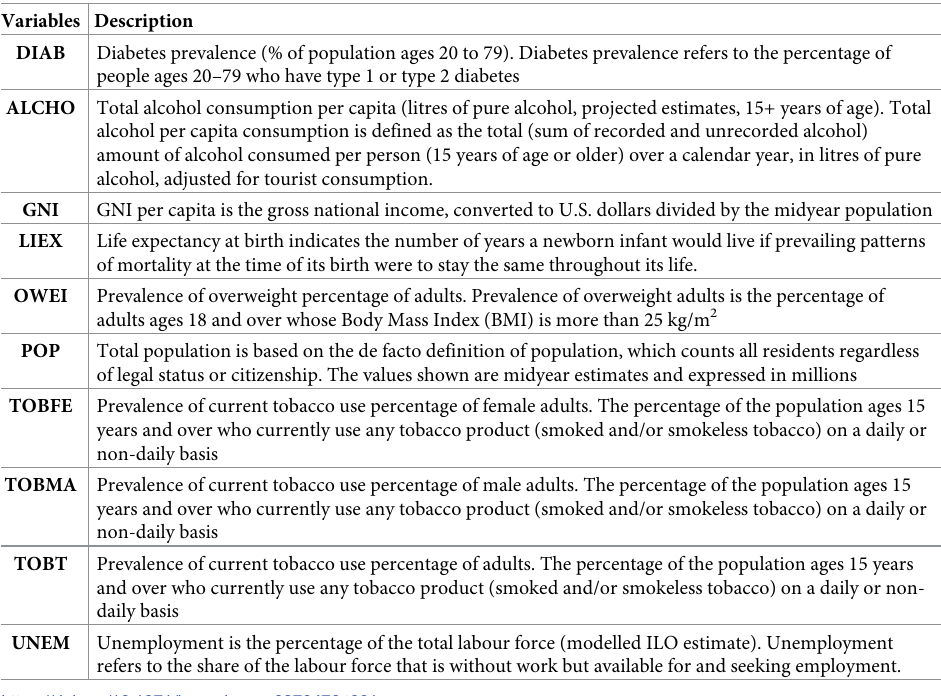
Table 1. Lifestyle and socioeconomic variables used in MLR models. Data obtained from countrywide Health Nutrition and Population Statistics data. Variables